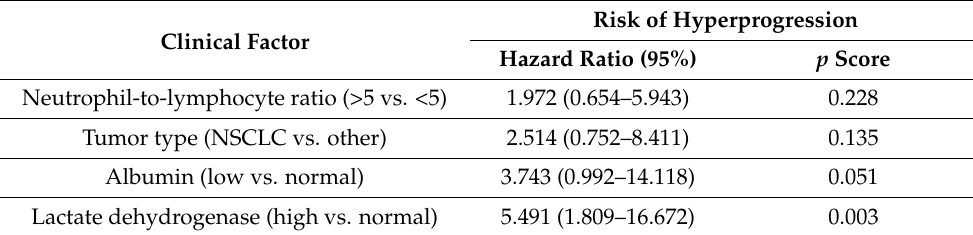
Table 3. Multivariate analysis of factors associated with hyperprogression.